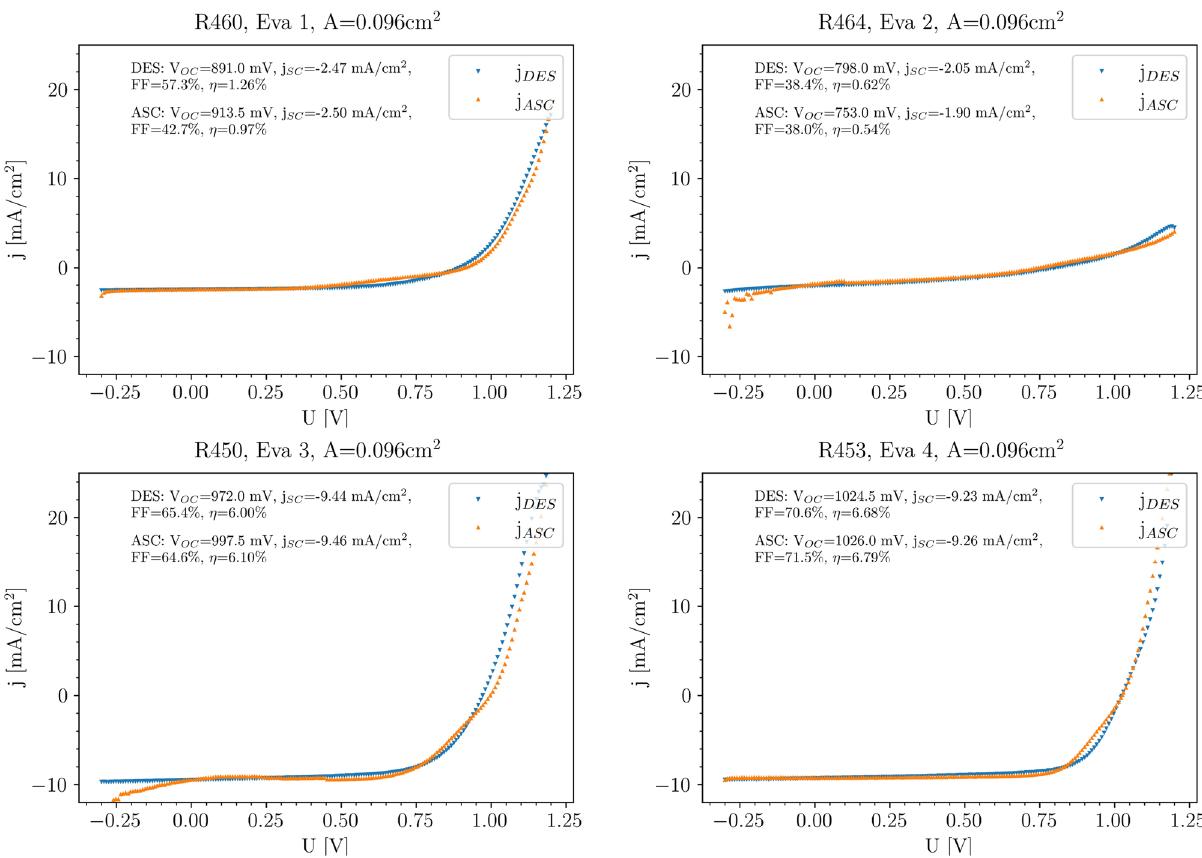
Figure 6. j-V characterisation of Eva 1 (top left), Eva 2 (top right), Eva 3 (bottom left) and Eva 4 (bottom right).